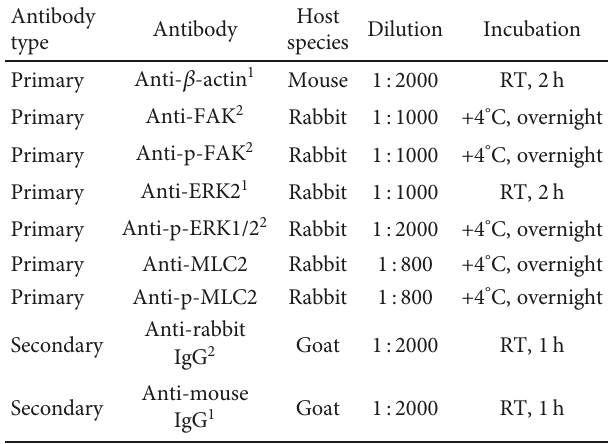
Table 3: Primary and secondary antibodies used in Western blot